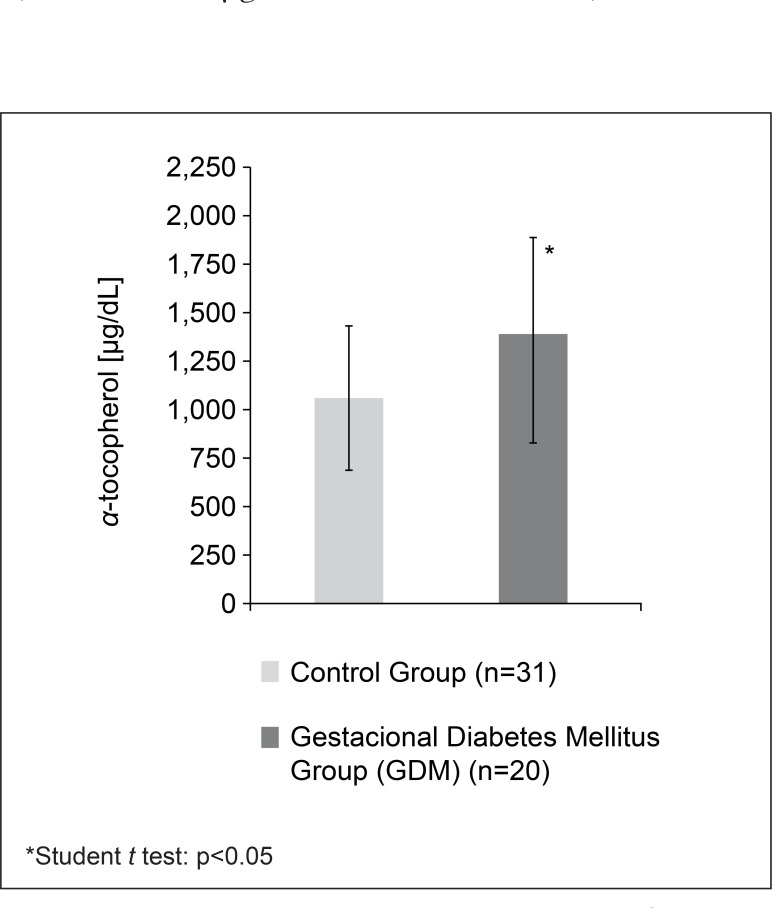
Concentração de a-tocoferol no soro de lactantes do Grupo Controle e do
Grupo de Diabetes Melito Gestacional